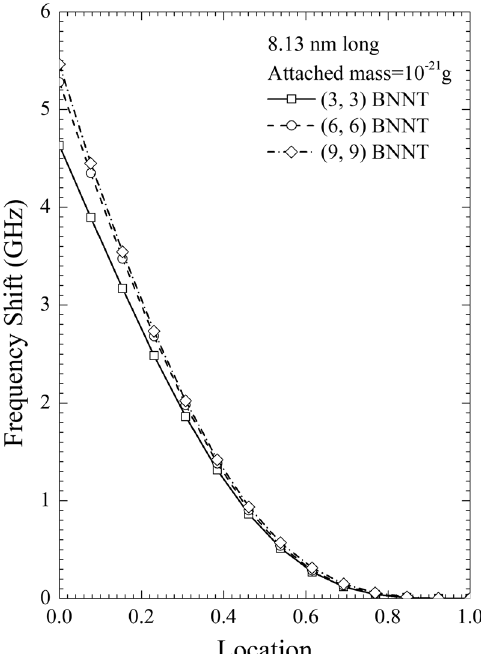
Figure 12: The variations of resonant frequency shift for ( 3,3 ) , ( 6,6 ) , and ( 9,9 ) cantilevered SW - BNNT with length 8.13 nm with an extra mass of 10 − 21 g versus di ff erent attached positions on the